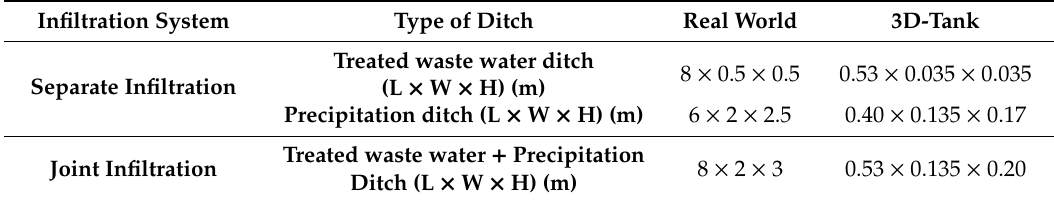
Table 3. Dimensions of the real world and downscaled 3D-Tank infiltration